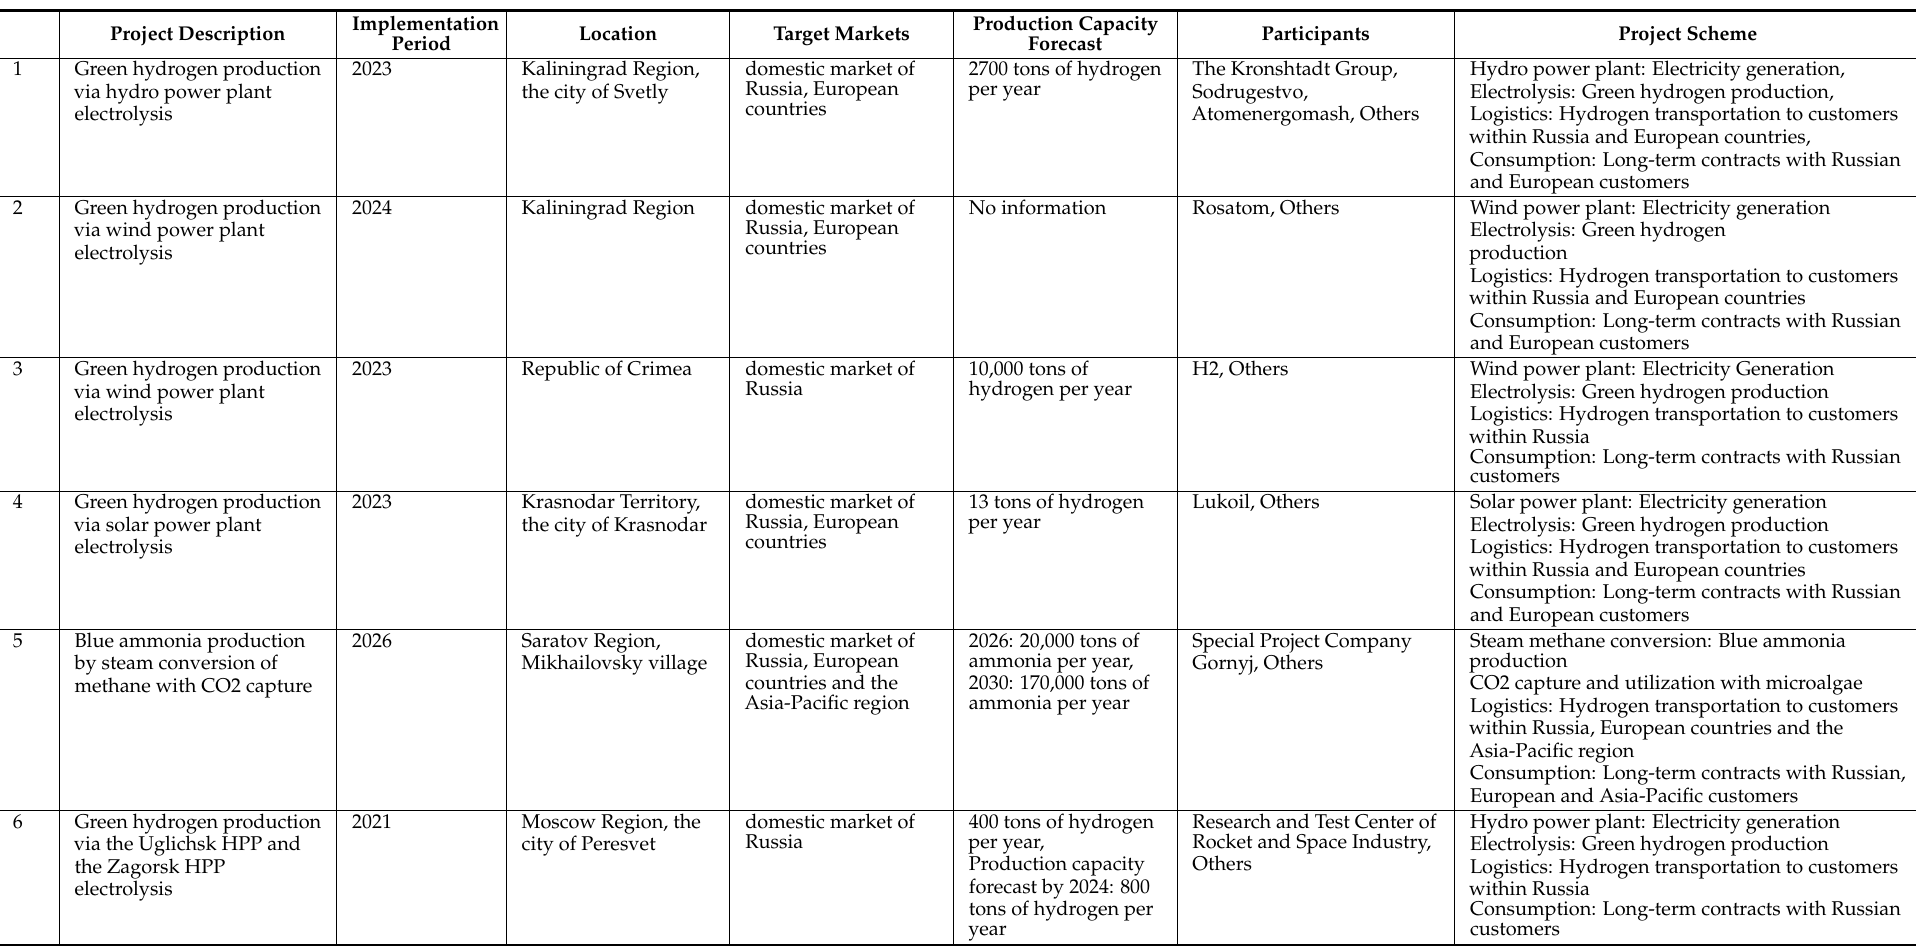
Table A1. Hydrogen projects in